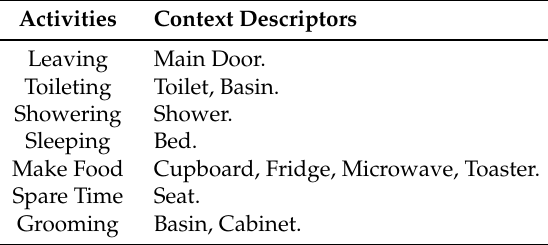
Table 7. Activity concepts and the discovered context descriptors for Ordonez House